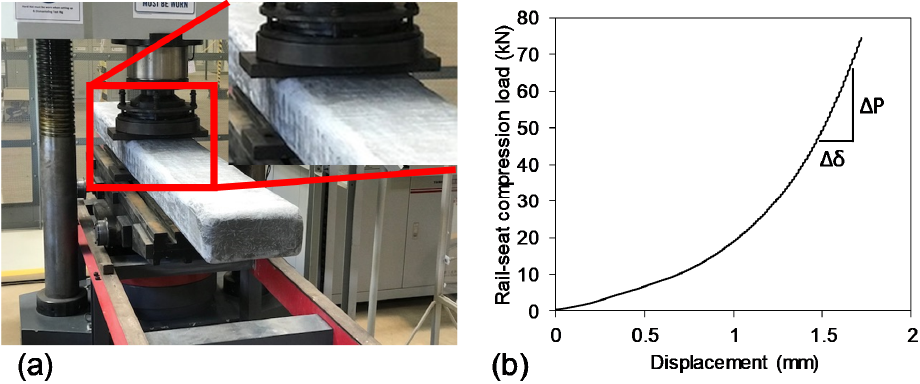
Figure 4. Rail-seat compression test ( a ) test setup and ( b ) load-displacement